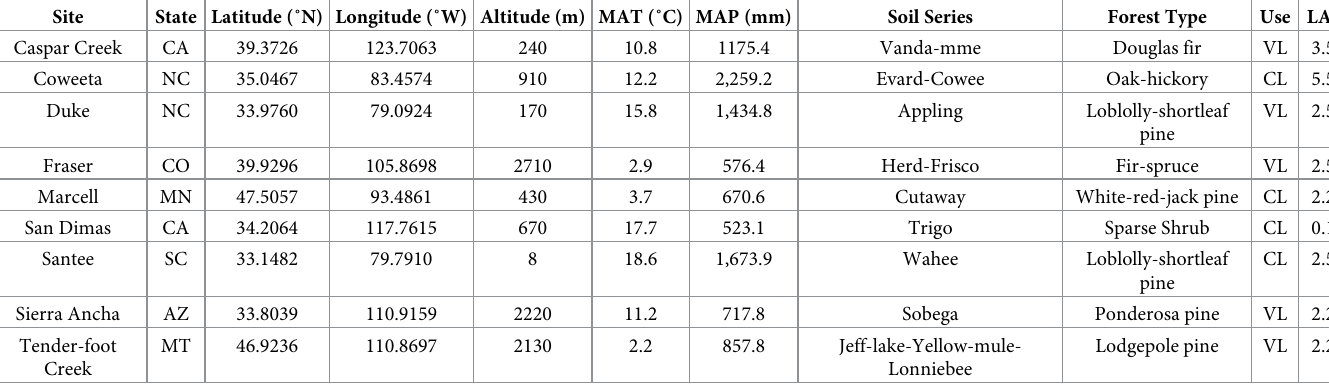
Table 1. Locations of FACE wood study sites used for model calibration and validation � . Site